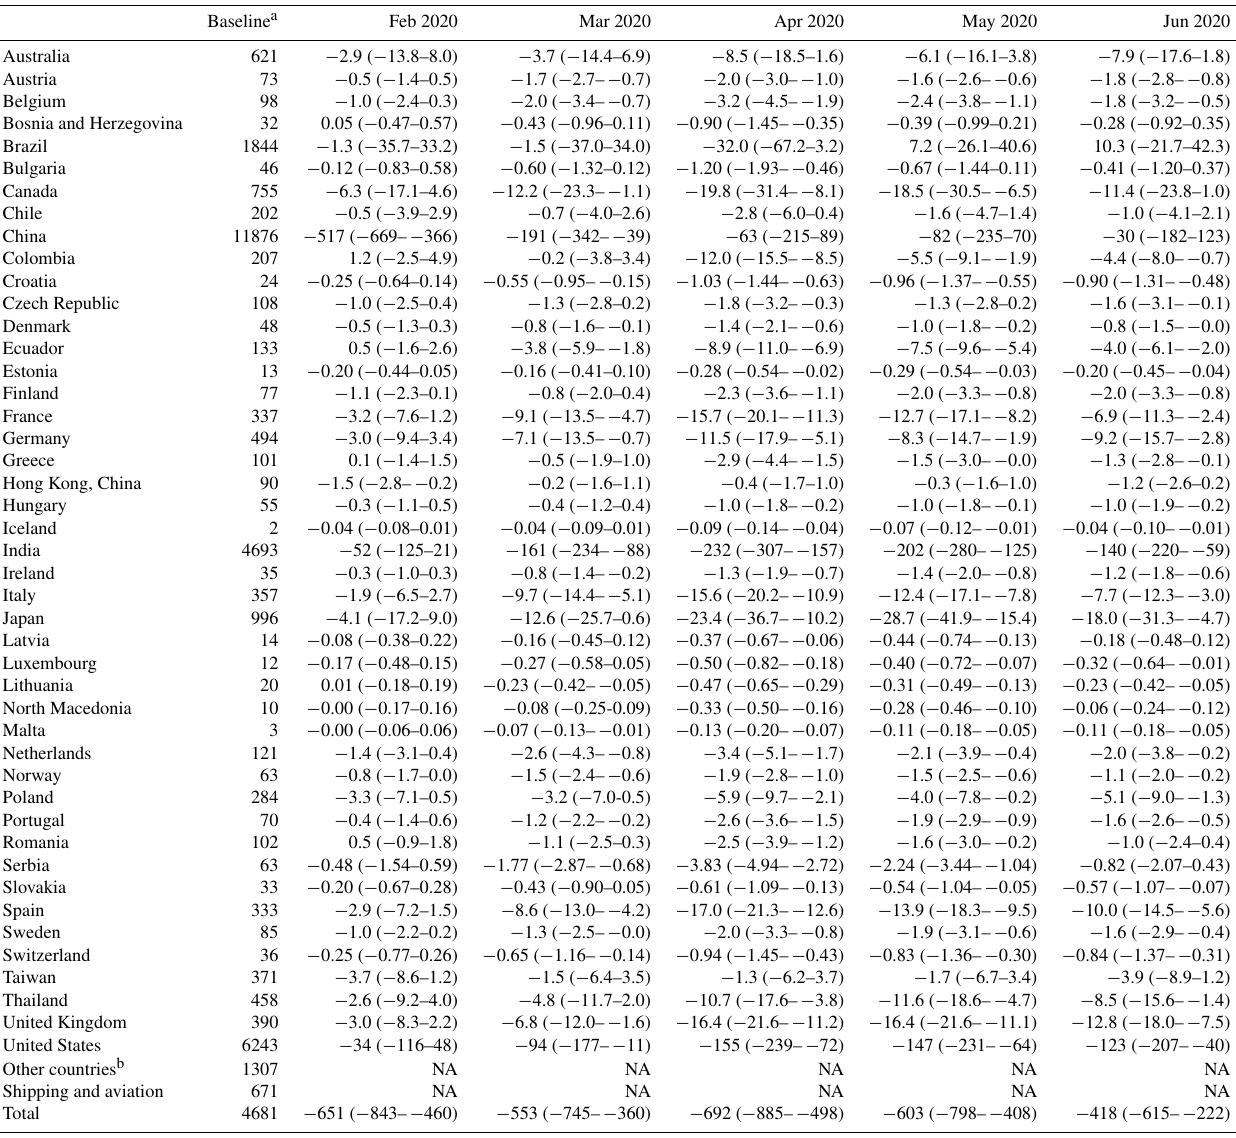
Table 2. Anthropogenic NO x emission reductions in GgN month − 1 as derived from NO 2 concentration changes. Baseline